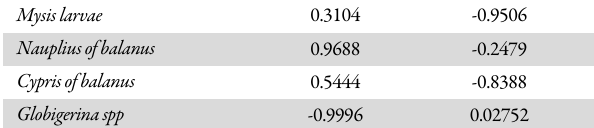
Table 1. Eigene analyses of the correlation matrix loadings of the significant principal components in post-monsoon season